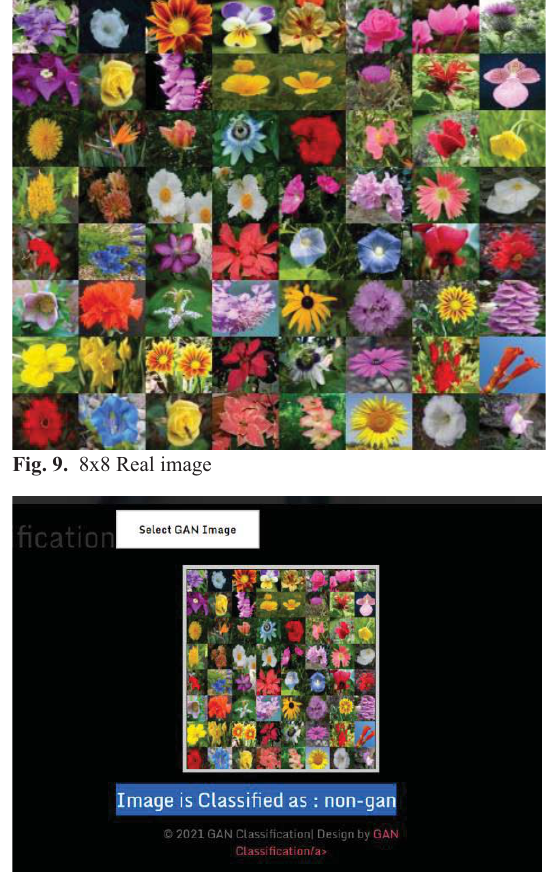
Fig. 10. The result on the web app (Real Image) Fig 9. depicts 8x8 real image i.e 64 real images clustered together in 8x8 format. Fig 10. depicts the result of the web app for the real image. We can observe from the above result that the image has been classified as a non- gan or not artificially produced image.